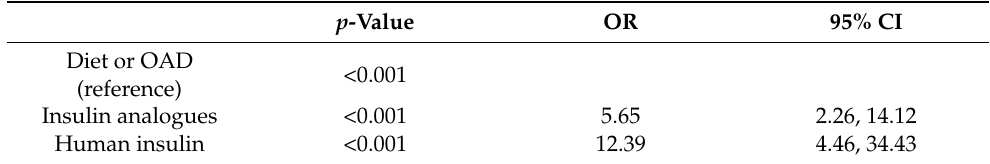
Table 5. Risk of DR according to type of insulin.